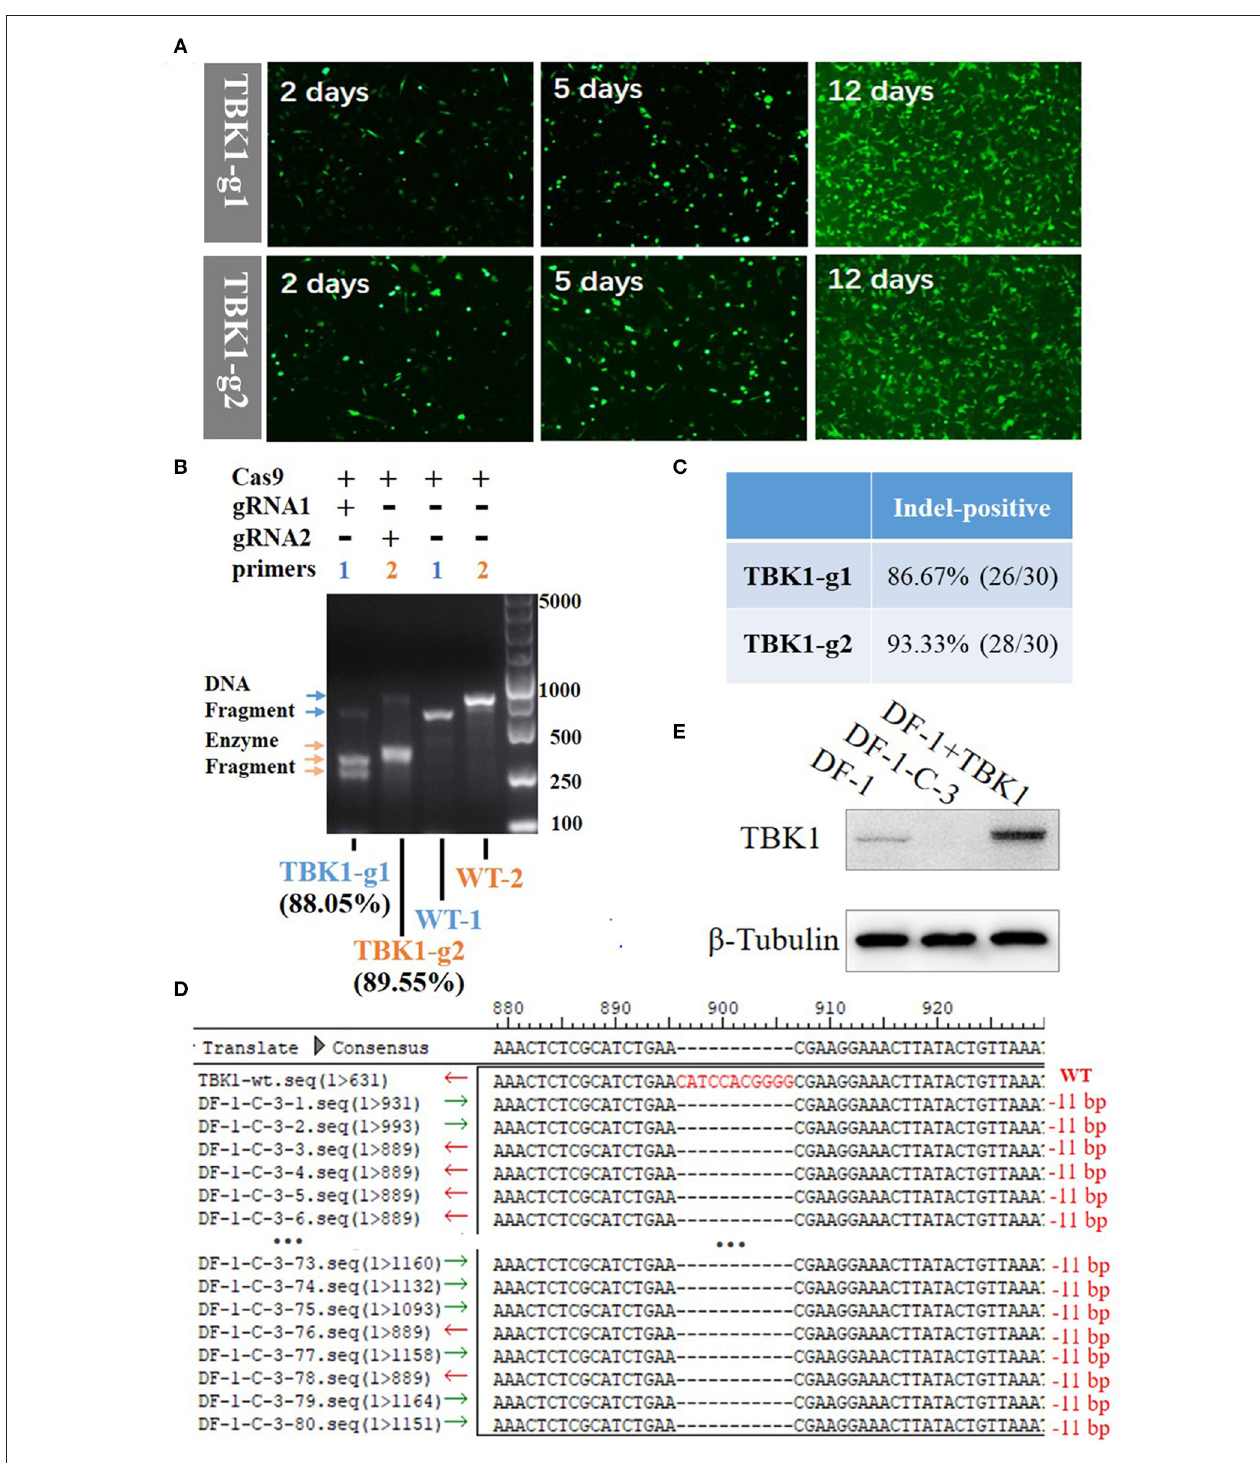
FIGURE 2 | Generation and identification of chTBK1 knockout DF-1 cell line, DF-1-TBK1-C3. (A) Mutant cell enrichment using puromycin screening. (B) Results of T7EI assay showing high knockout efficiency of both gRNA-1 and gRNA-2. (C) Evaluation of knockout efficiency of TBK1-g1 and TBK1-g2 by cloning and sequencing. (D) Sequencing results of targeted regions of DF-1-TBK1-C3 monoclonal cells. Alignment of DNA sequences between wild-type and DF-1-TBK1-C3 cells showed homozygous mutation with an 11-bp deletion. (E) The chTBK1 protein was not detectable in DF-1-TBK1-C3 cells by Western blot analysis.